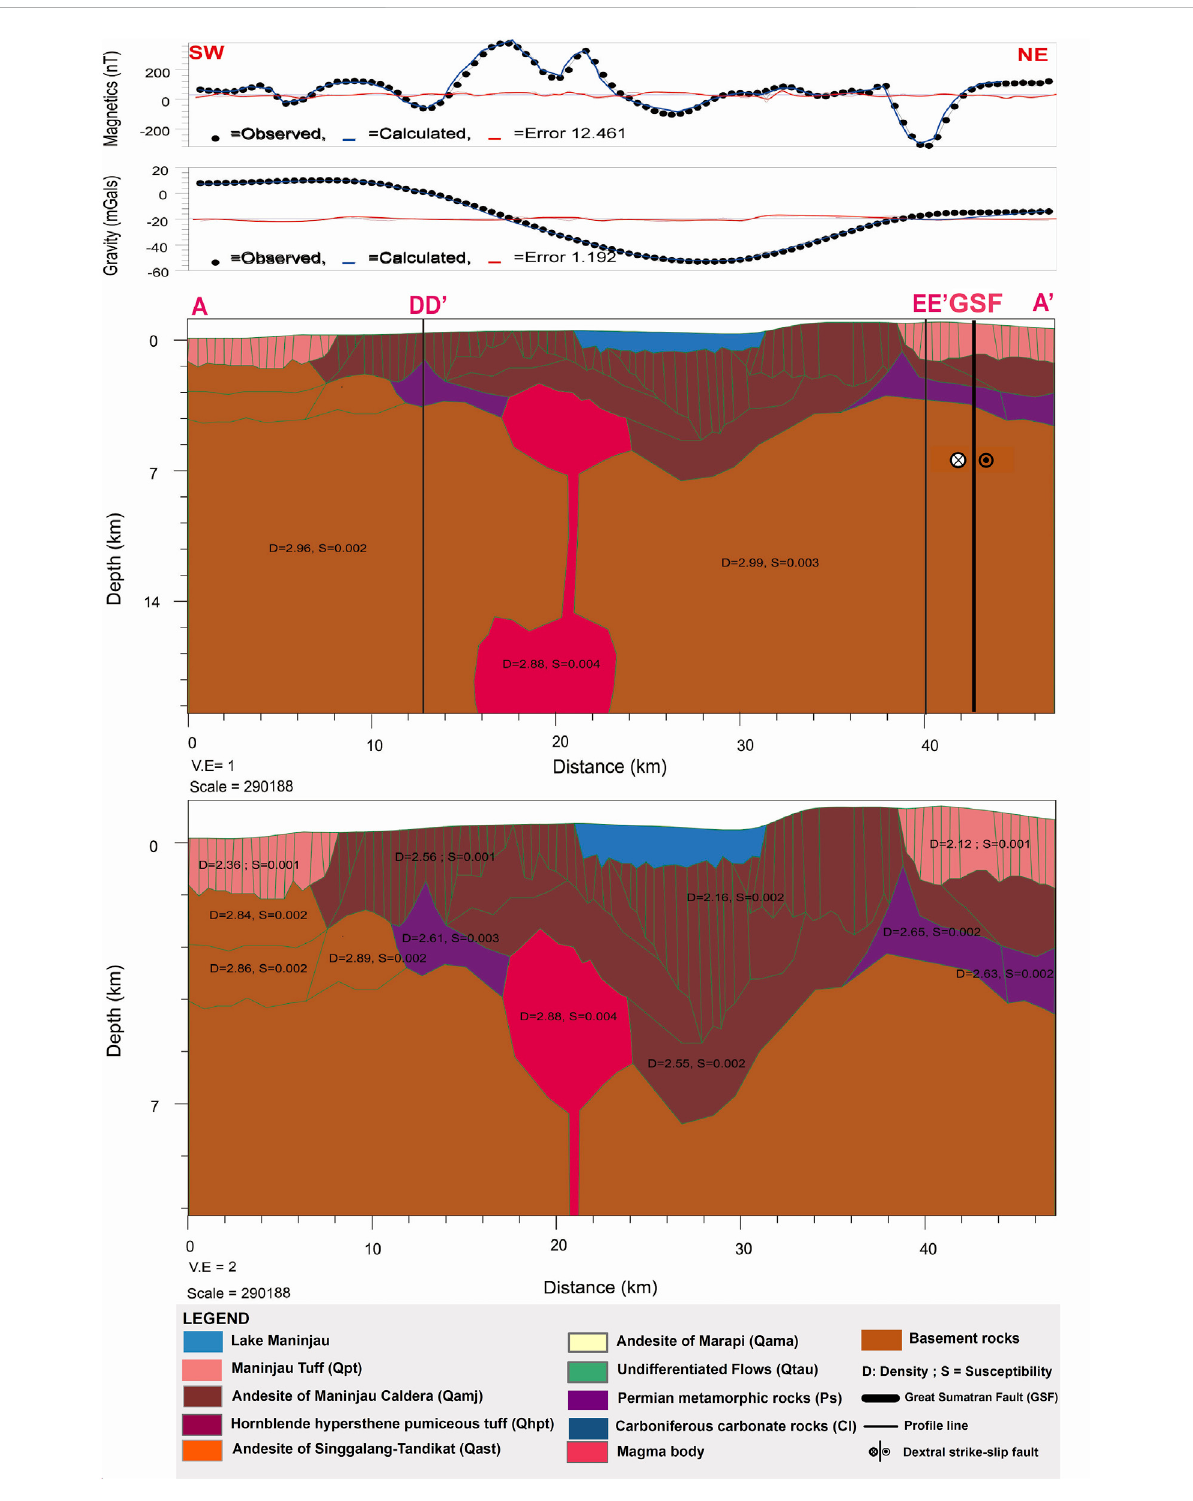
FIGURE 3 2DmodelingofmagneticandgravitydataoftheA-A ′ pro fi leintheSianoksegmentofGSFshowingthesubsurfacestructuresbeneathManinjau Caldera that include shallow and deep magma chambers. Models are presented in a more general 20 km deep image and a more detailed 10 km deep